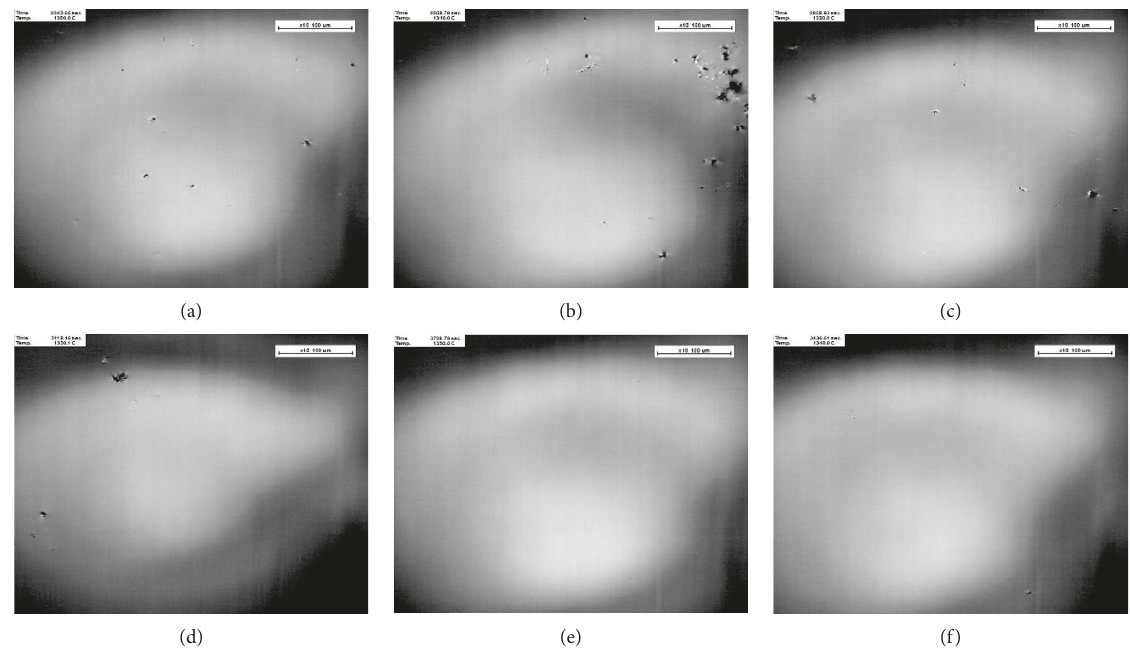
Figure 5: The evolution rules of morphology with 2% B